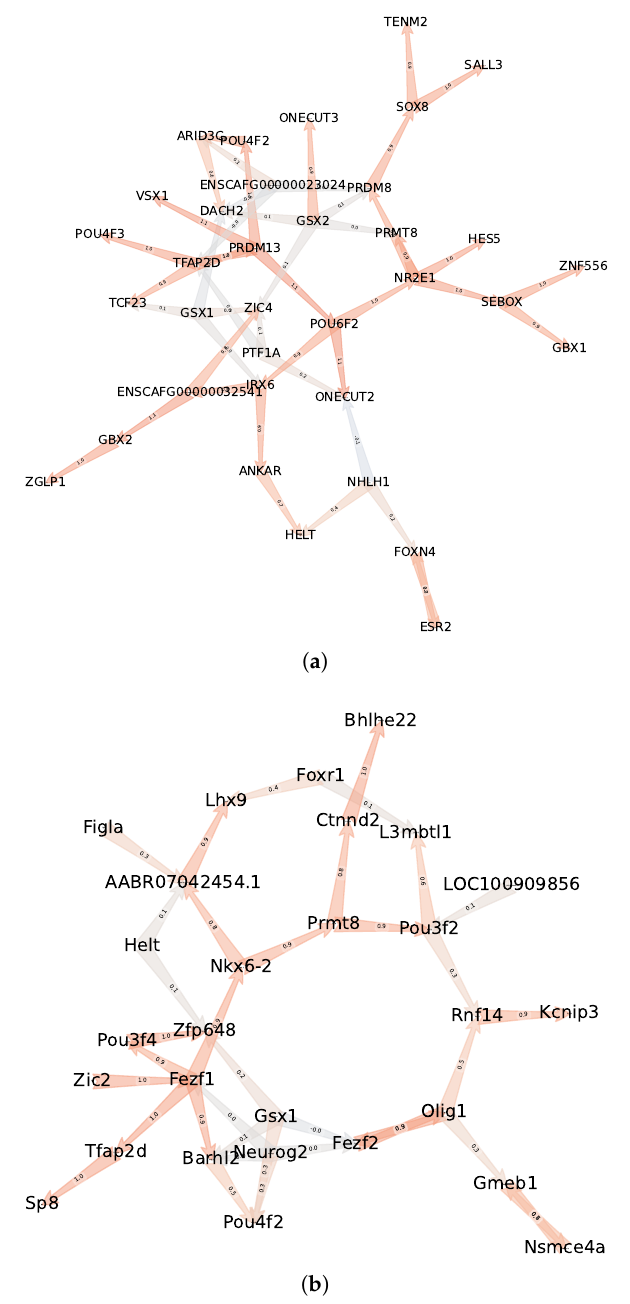
Figure 10. Regulatory communities Cf | 23 ( a ) and Rn | 39 ( b ) obtained applying GXN•OMP on the C. familiaris and R. norvegicus datasets respectively. The communities Cf | 23 exhibits enriched GO terms related to neuroretina and retina development, while Rn | 39 exhibits enriched GO